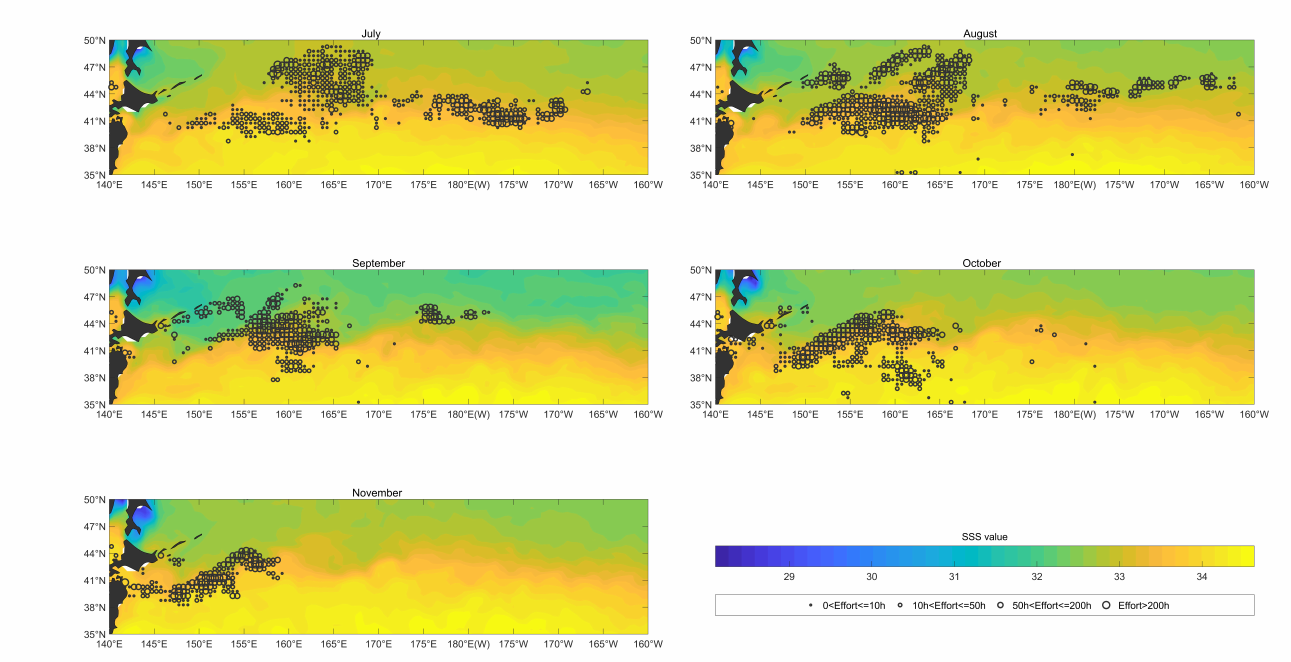
Figure 7. The overlay map of SSS (color shading; units: dimensionless) and monthly fishing efforts (circle; units: h) of O. bartramii in the North Pacific Ocean from July to November from 2017 to